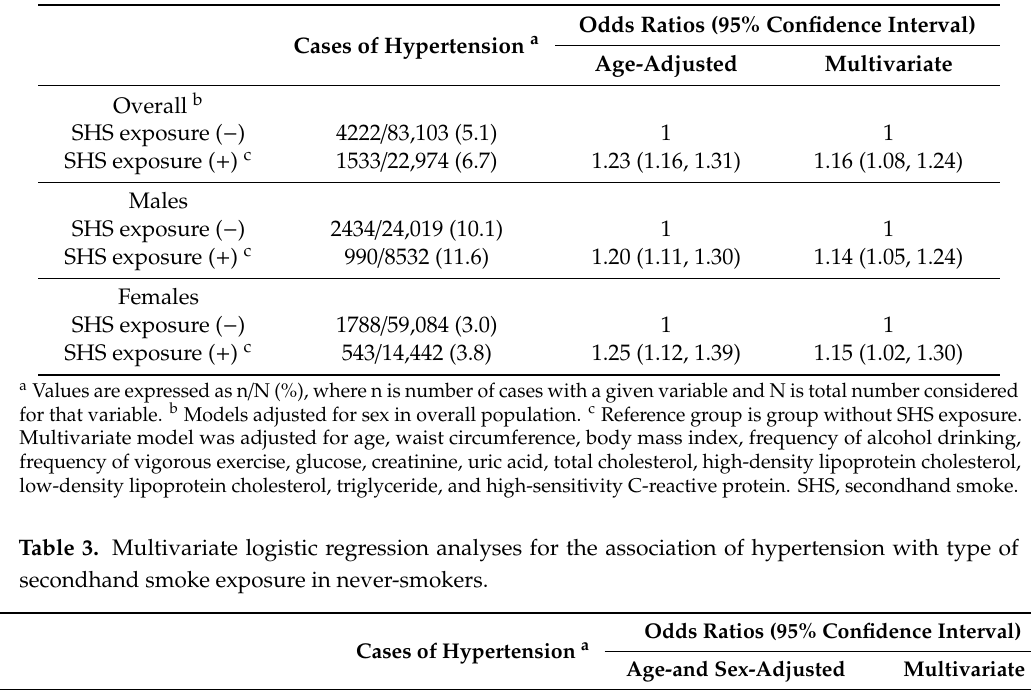
Table 2. Multivariate logistic regression analyses for the association of hypertension with secondhand smoke exposure in never-smokers.